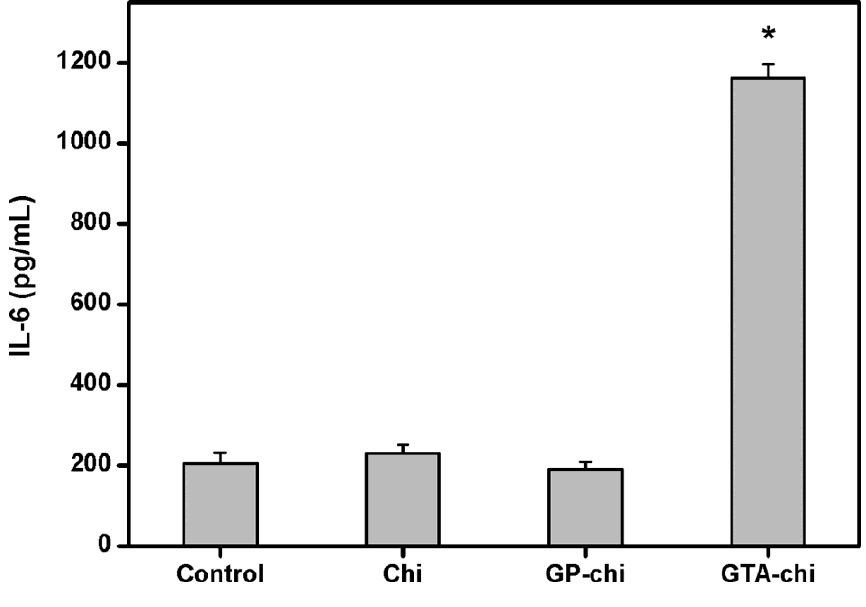
Figure 7. Level of IL-6 released from ARPE-19 cell cultures after incubation with various chitosan membranes (5 mg) for 3 days. An asterisk indicates statistically significant differences (* p < 0.05; n = 4) as compared to controls (without